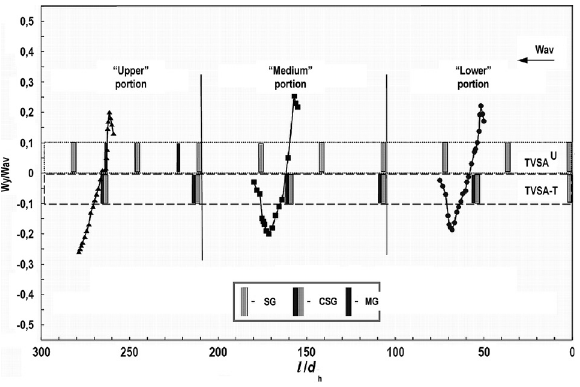
= 27.5 m/s, Re = 78000). av